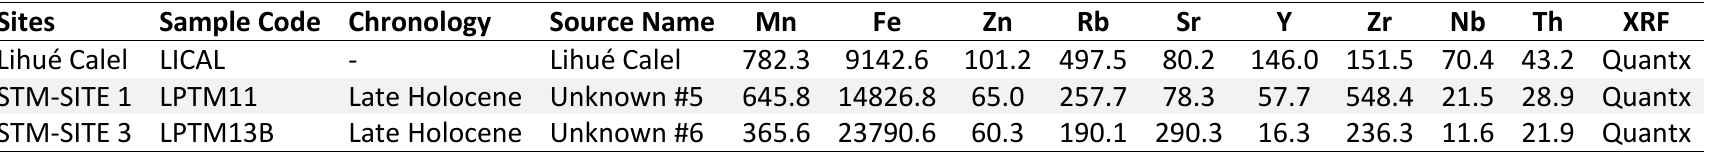
Table 4. Results obtained from XRF (Quantum